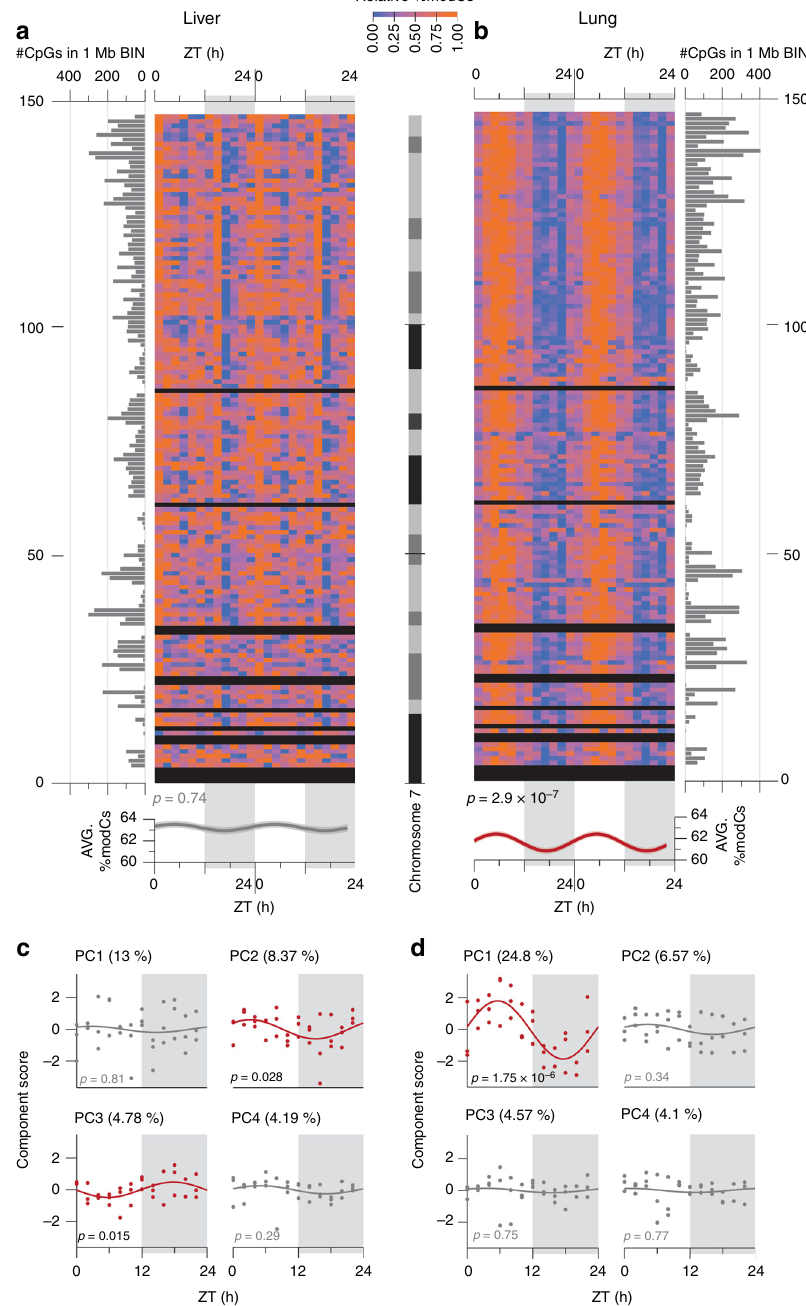
Fig. 3 Global patterns of oscillations in the 9-mo mouse liver and lung. a , b A heatmap of the mean modi fi cation densities of epigenetically variable cytosines (EVCs) across chromosome 7 of a the liver and b the lung, normalized to a range of 0 – 1 in each 1 Mb bin. The horizontal bar plots display the number of EVCs in each bin (bins with no EVCs appear black in the heatmap). The plots in the bottom panel display the chromosome-wide means of cytosine modi fi cation as a function of ZT, fi tted using the harmonic regression model. The shading around the regression lines represents the 95% con fi dence band. All data were double plotted to aid with visualization. ZT, Zeitgeber time; modC, cytosine modi fi